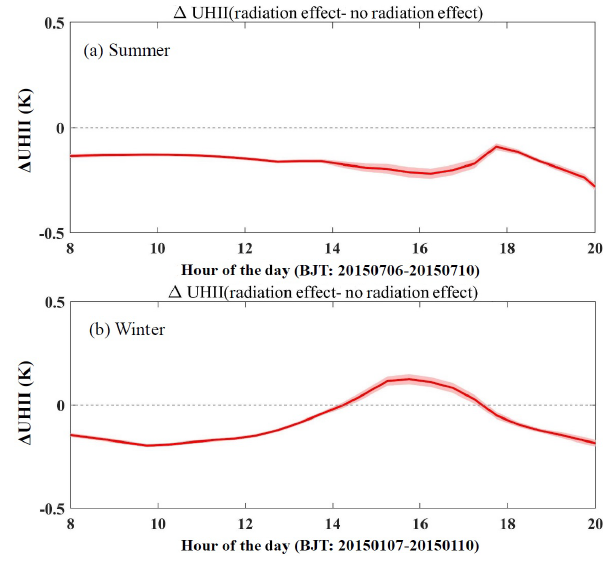
Figure 12. Average diurnal variations in UHII differences ( (cid:49) UHII; unit: K) between UHII with and without including ARE for typical days in (a) summer (averaged over 6–10 July 2015) and (b) winter (averaged over 7–10 January 2015).